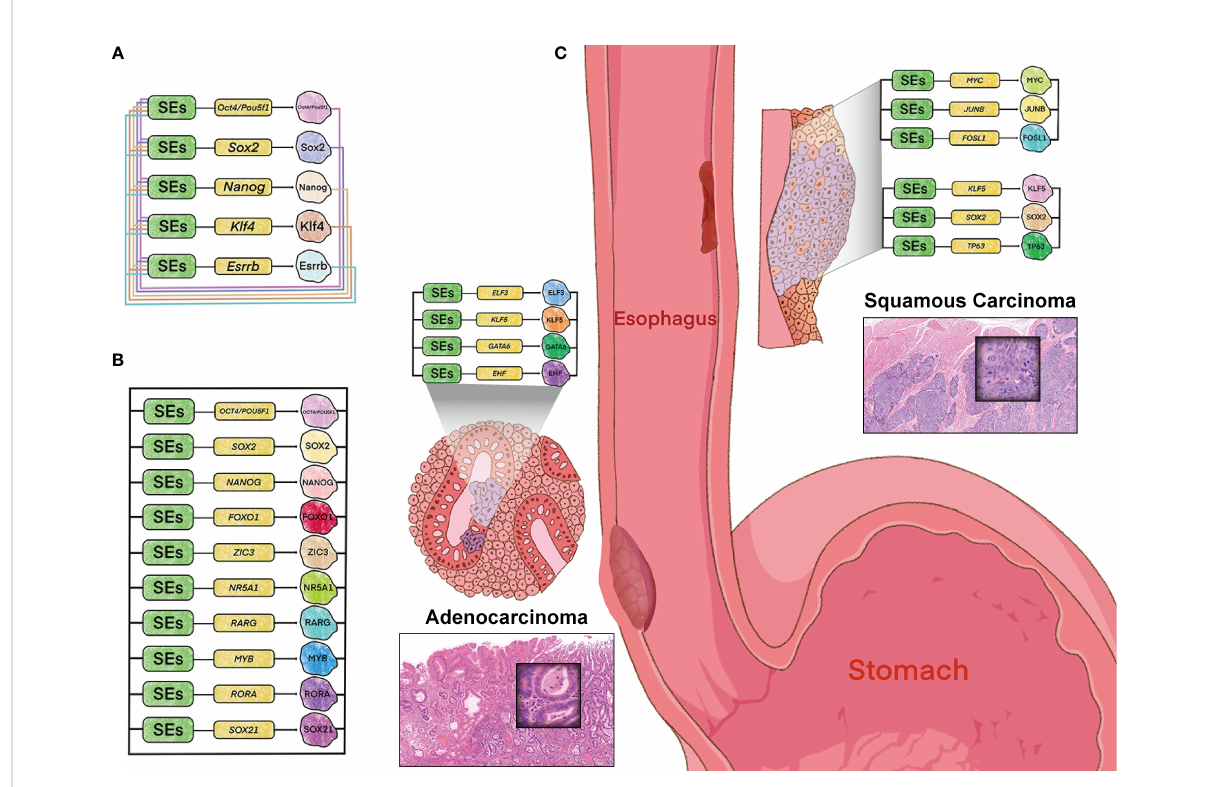
FIGURE 2 Model of core regulatory circuitry and its implications in esophageal tumorigenesis. (A) CRC model in murine embryonic stem cells. (B) CRC model in human embryonic stem cells identi fi ed by “ CRC Mapper ” algorithm. (C) Histopathology- and cell-type-speci fi c CRC in esophageal carcinoma, including adenocarcinoma (left) and squamous cell carcinoma (right). Hematoxylin-eosin stain (magni fi cation x